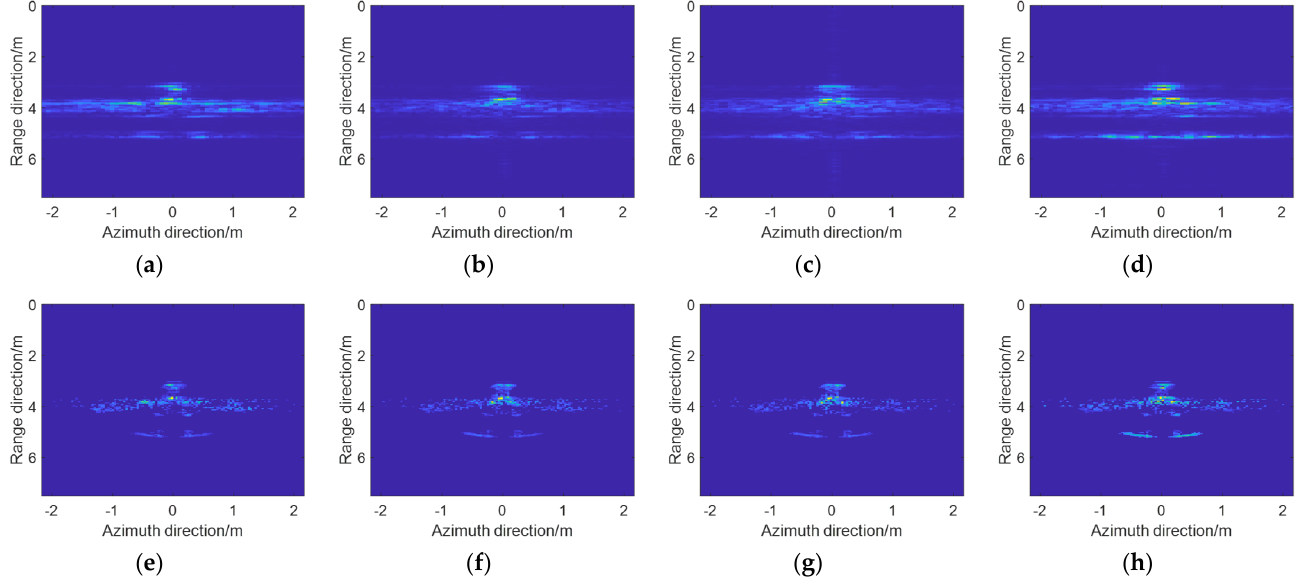
Figure 12. Imaging results of UAV with sparse aperture extraction: ( a–d ) represent the imaging results using RD algorithm in HH, HV, VH and VV polarization channels, respectively; ( e–h ) represent the imaging results using CAS-OMP algorithm in HH, HV, VH and VV polarization channels, respectively.